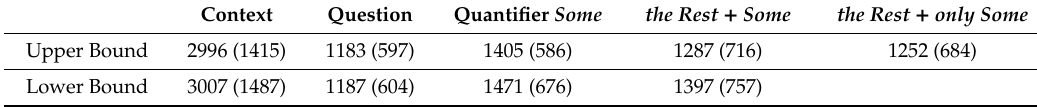
Table 3. Summary of results of the self-paced reading task. Reading times in ms. (SD in